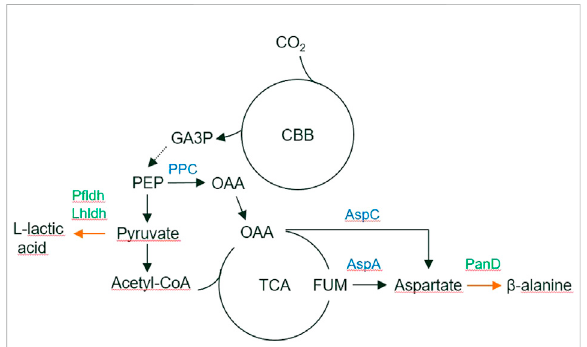
FIGURE 1 The biosynthetic pathways for L-lactic acid and beta-alanine production from CO 2 . Overexpressed genes are marked by green. Abbreviations: CBB, Calvin – Benson – Bassham cycle; GA3P, glyceraldehyde 3-phosphate; PEP, phophoenolpyruvate; OAA, oxaloacetate; TCA, tricarboxylic acid cycle; FUM, fumarate; PPC, phosphoenolpyruvate carboxykinase; P fl dh, P. falciparum L-lactate dehydrogenase; Lhldh, L. helveticus